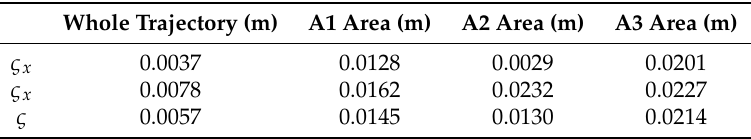
Table 2. The errors of path tracking algorithm.